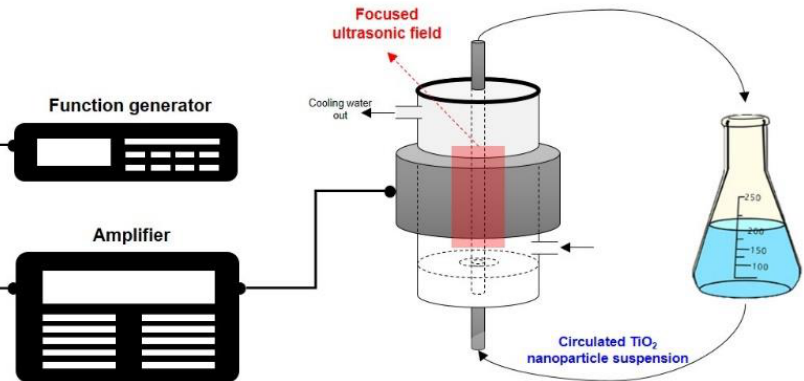
Figure 4. Schematic of the ultrasonic dispersion equipment for TiO 2 nanoparticle in deionized water. Table 3. Experimental conditions used for ultrasonic dispersion.